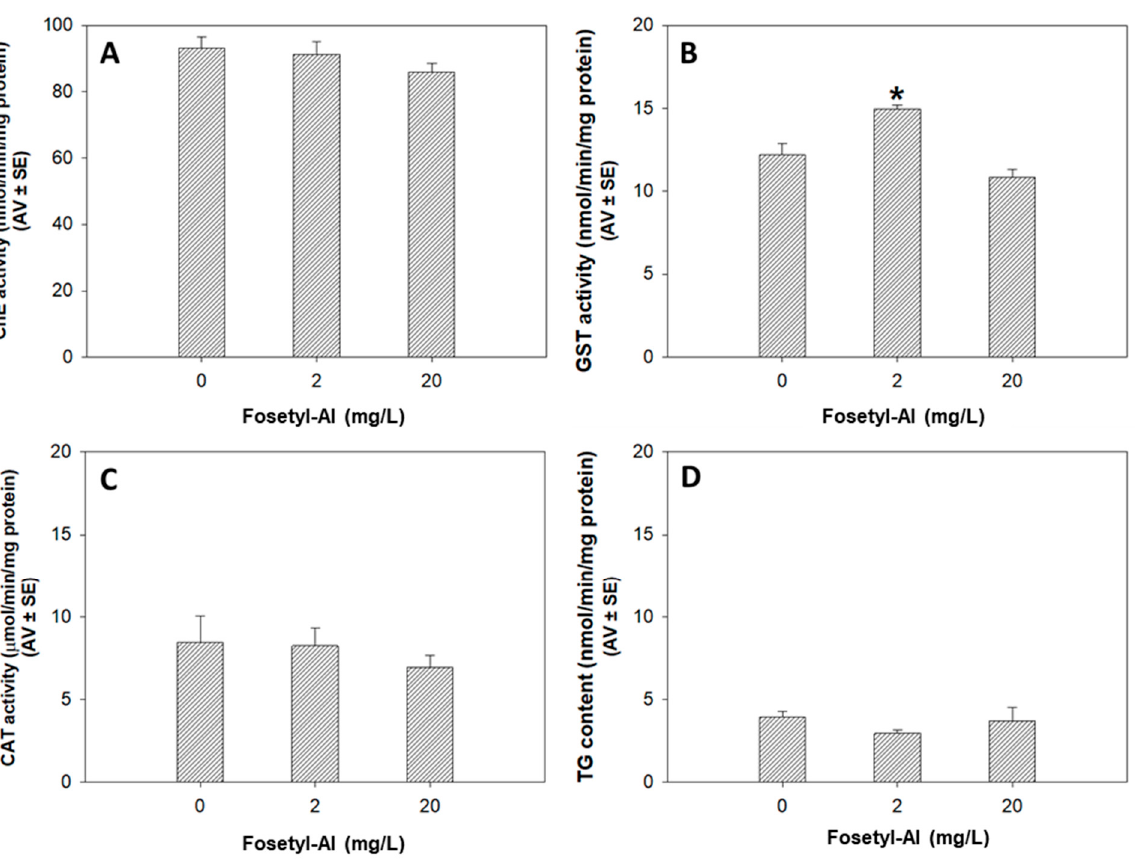
Figure 4. Effects of 96 h pf exposure to fosetyl-Al on zebrafish larvae for cholinesterase (ChE) ( A ); glutathione S -transferase (GST) ( B ); catalase (CAT) ( C ) activities; and total glutathione (TG) content ( D ). Data are expressed as average value (AV) ± standard error (SE). * Significant differences to control ( p < 0.05).